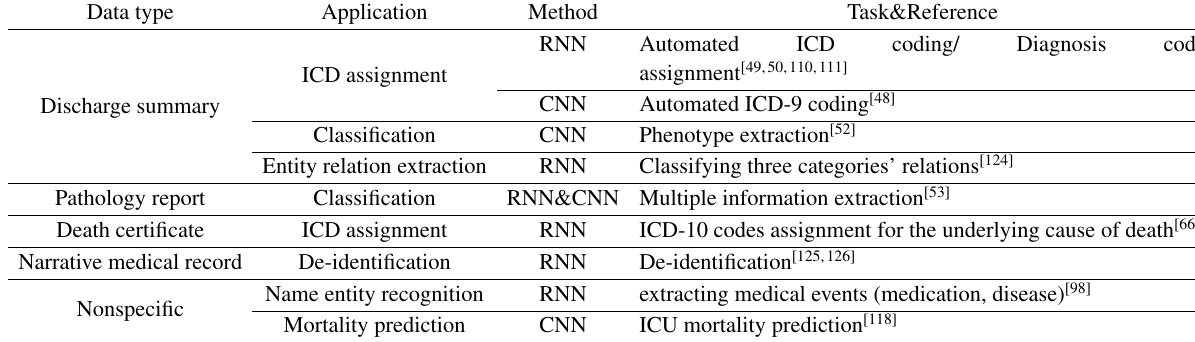
Table 3 Overview of deep learning methods applied on clinical notes.